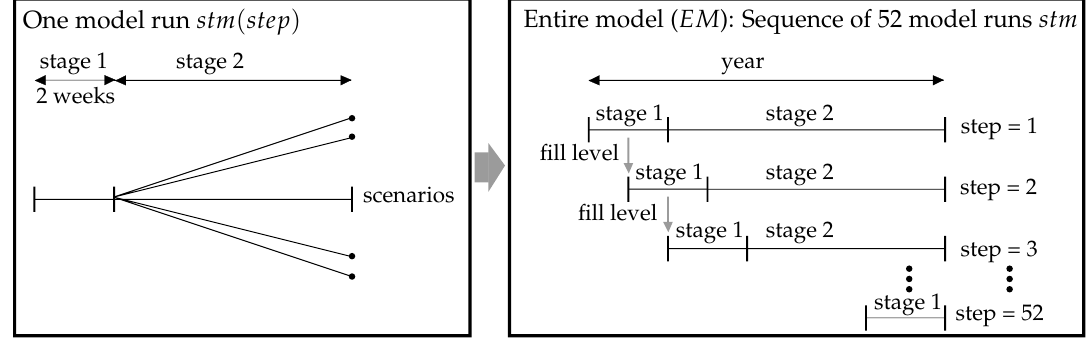
Figure 1. Stochastic model with a 2-stage stochastic dual dynamic programming (SDDP)